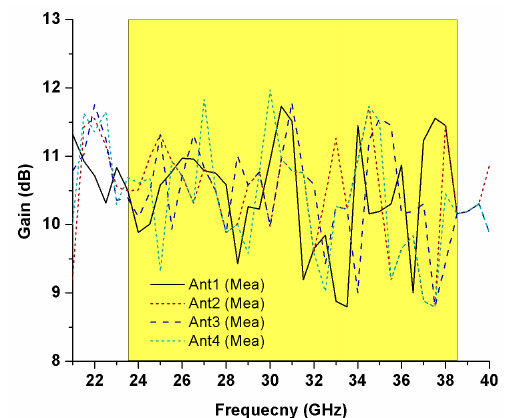
Figure 11. Maximum gain over frequency of the MIMO antenna elements.